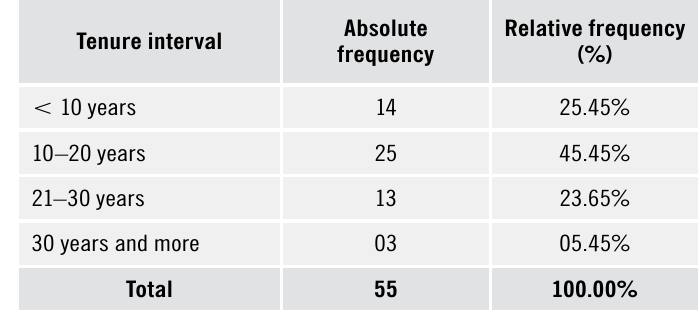
Table 6. CEO by different tenure groups